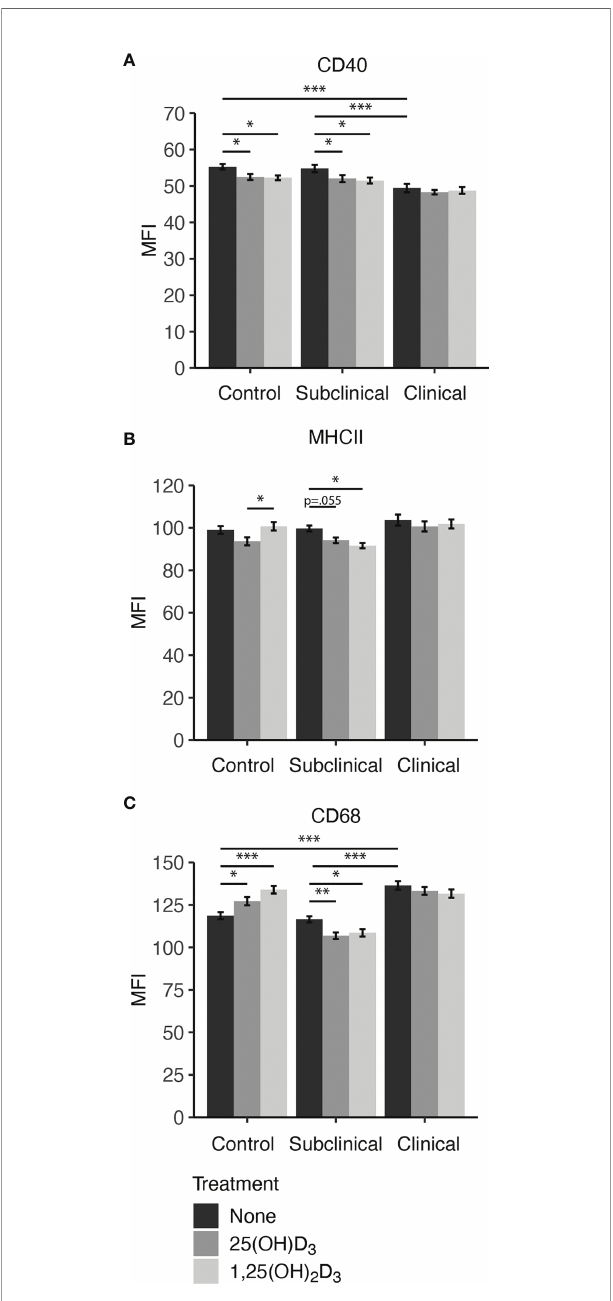
FIGURE 4 | Macrophage expression of activation markers (A) CD40, (B) MHCII, and pan-macrophage marker (C) CD68. Peripheral blood mononuclear cells (PBMCs) were isolated from the whole blood of dairy cattle naturally infected with Mycobacterium avium subsp. paratuberculosis (MAP) (clinical n=7, subclinical n=8) or noninfected controls (n=6). Cells were cultured 5-6 days to generate monocyte-derived macrophages (MDMs), pre- treated with vitamin D 3 as detailed in methods, then incubated 24 hrs with live MAP ± 25(OH)D 3 or ± 1,25(OH) 2 D 3 . The mean fl uorescence intensity (MFI) for each target was measured using marker speci fi c primary antibodies coupled with an Alexa Fluor labeled secondary antibody (MHCII[AF488]; CD68 [AF594]), or biotin labeled secondary and NeutrAvidin-DyLight 650 tertiary antibody (CD40). Data are presented as the MFI ± SE and signi fi cance levels are as follows: *< 0.05, **< 0.01, ***<